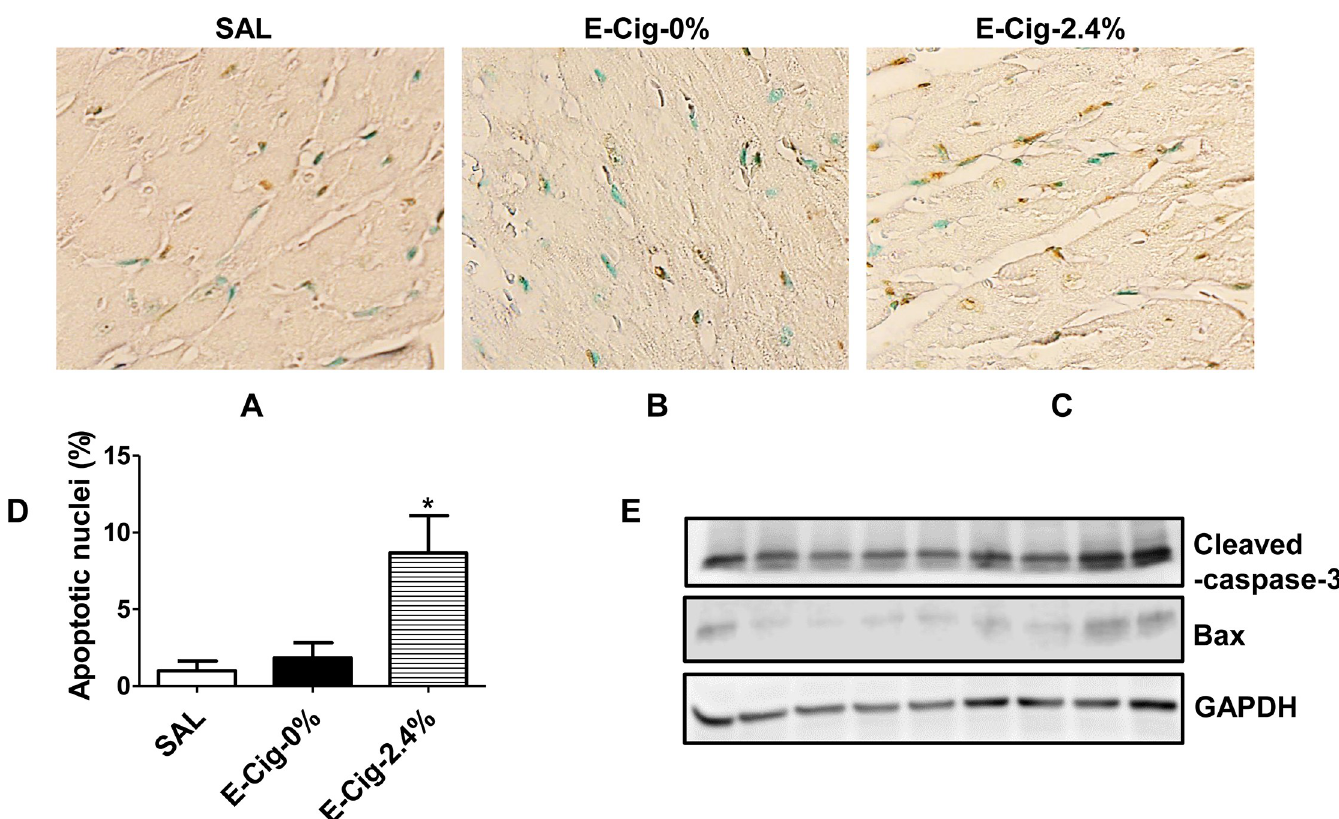
Fig 3. E-cigarettes (2.4% nicotine) trigger CM apoptosis. Compared to mice exposed to saline ( A ) or e-cigarette (0% nicotine) aerosol ( B ), where little or no apoptosis is detected, a significant increase in CM apoptosis ( C ) was detected in mice exposed to e-cigarettes (2.4% nicotine). Scale bar = 25 μ m. ( D ) Quantitation of CM apoptosis. Values are given as means ± SE of 5 mice per group. � P < 0.05. ( E ) Western blot analysis of active (cleaved) caspase